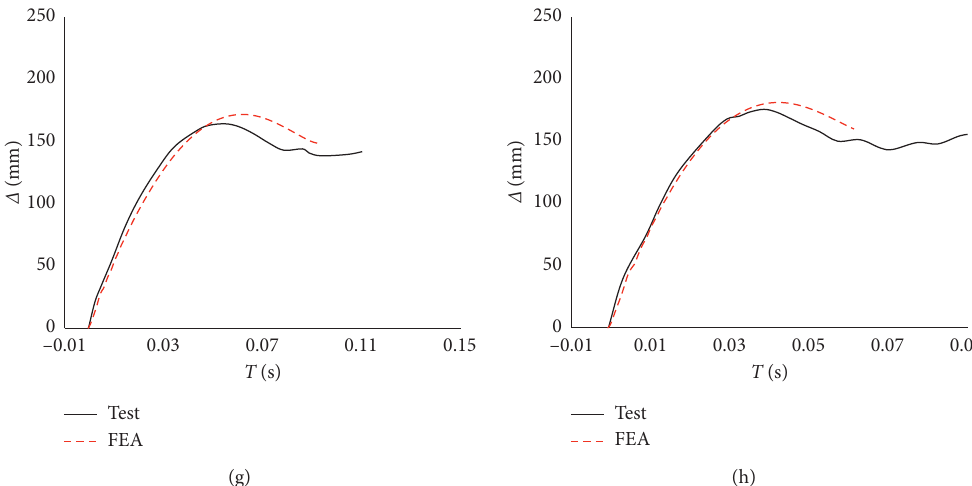
Figure 2: Lateral displacement ( Δ ) versus time (T) curves. (a) MSH, (b) Pd1, (c) Pd2, (d) CC1, (e) CC2, (f) SS1, (g) SS2, and (h)